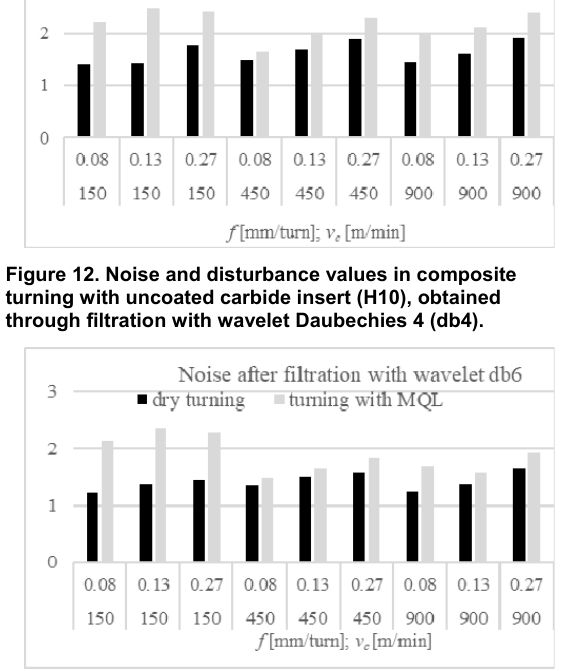
Figure 13. Noise and disturbance values in composite turning with uncoated carbide insert (H10), obtained through filtration with wavelet Daubechies 6